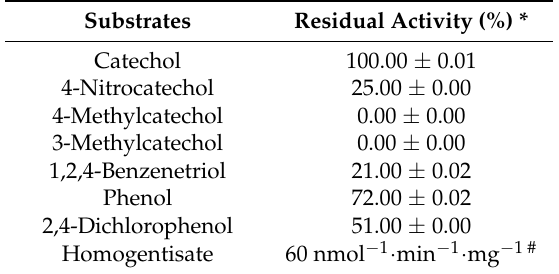
Table 3. Substrate specificity of purified C12O from Pc